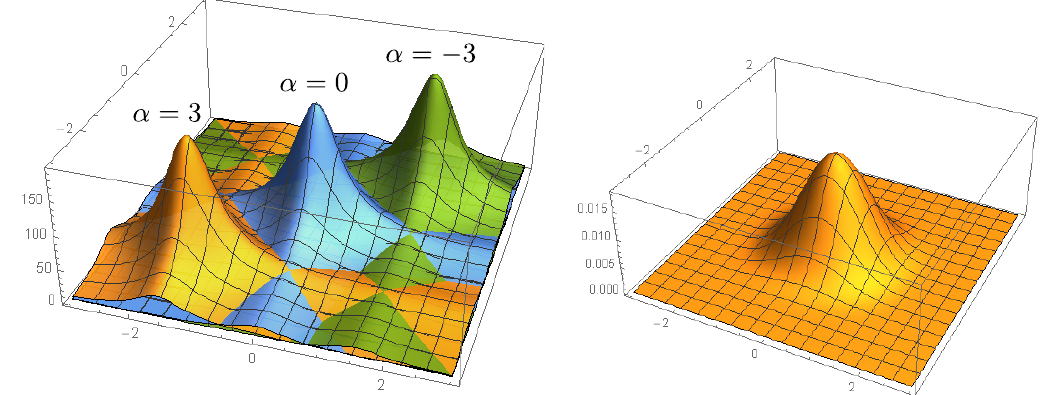
Figure 7 . Plot of f exp ( (cid:18) 1 ; (cid:18) 2 ) and f D ( (cid:18) 1 ; (cid:18) 2 ; (cid:11) ). Here we take mr = 1 and (cid:11) = 0 ; (cid:6) 3. is controlled by the parameter (cid:11) . If the peaks of f (cid:12)nite contribution to entanglement entropy, otherwise the contribution is negligible and we recover the bulk